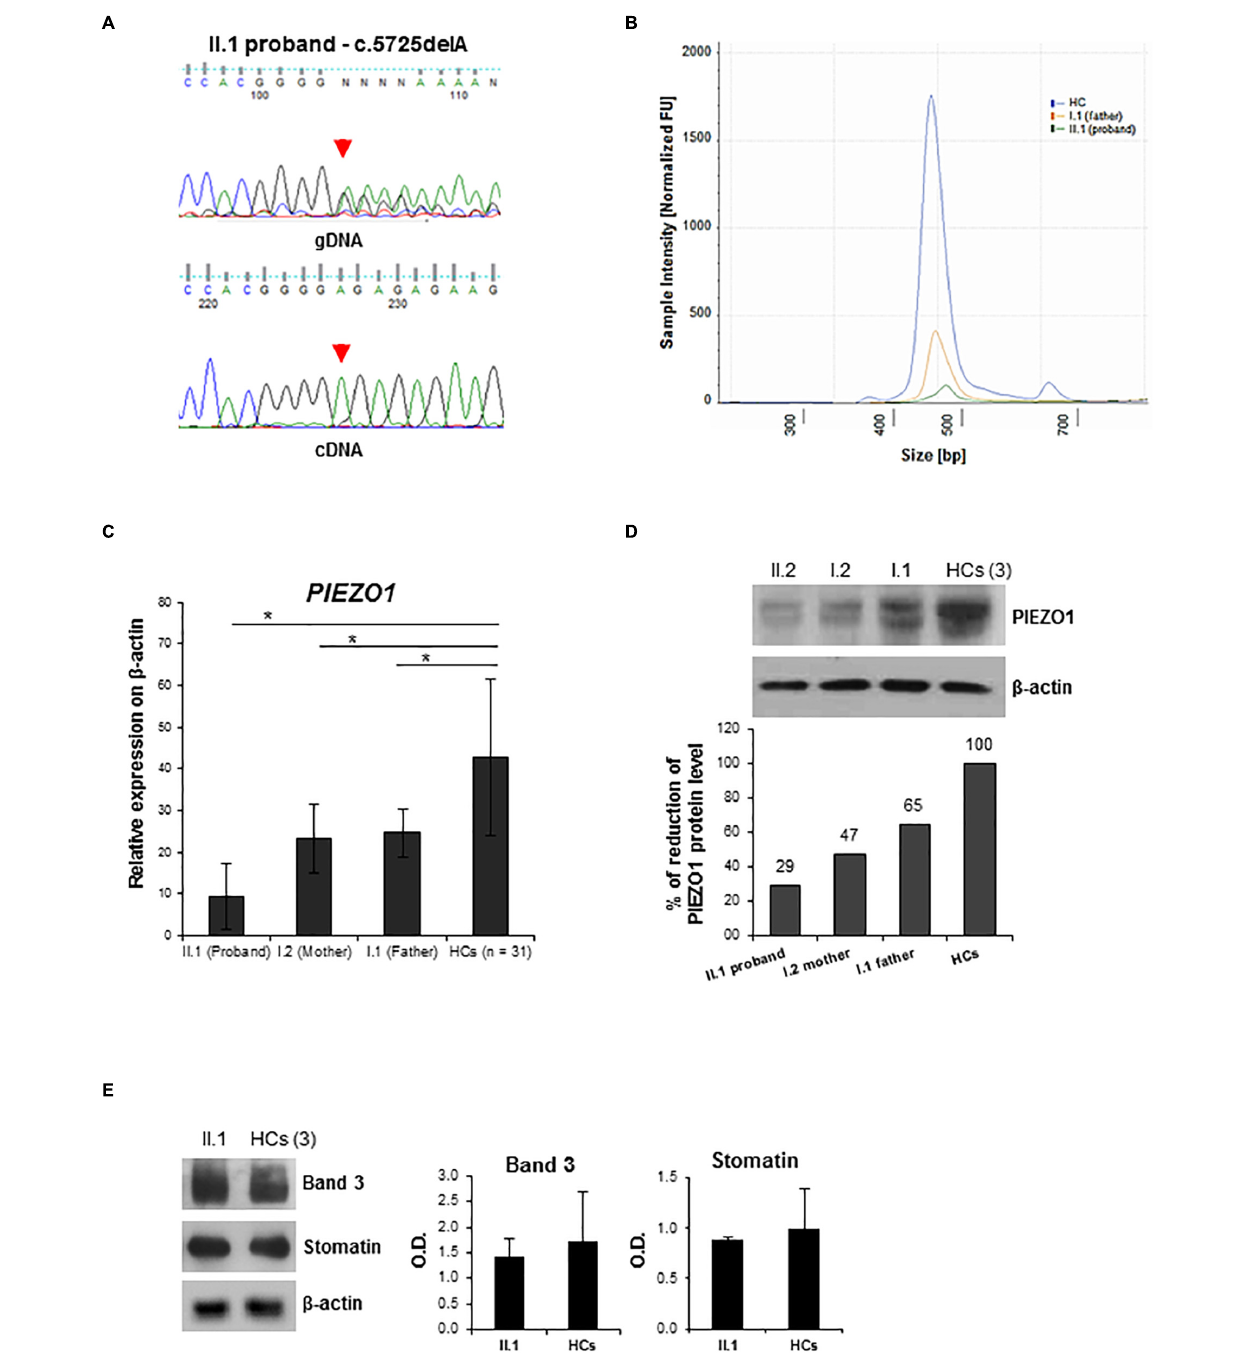
FIGURE 2 | Characterization of PIEZO1 mutations: cDNA study and membrane proteins expression analysis. (A) Electropherograms showing sequencing analysis of the PIEZO1 variant c.5725delA in the proband. Genomic DNA (gDNA) and cDNA sequences are shown. (B) DNA electrophoresis profile of the PIEZO1 cDNA fragment encompassing exons 42–44 of the proband (green line), the father (orange line), and the control (blu line) by 4200 TapeStation system. The electropherogram shows the size distribution and the intensity of the detected bands of RT-PCR. (C) PIEZO1 mRNA level normalized to GAPDH in the proband II.1 compared to his parents, I.1 and I.2 and the HCs ( n = 30). Data are presented as a mean ± SD. ∗ p -value < 0.05. (D) Immunoblot showing PIEZO1 protein expression normalized to β -actin in the proband II.1 compared to his parents, I.1 and I.2 and the HCs (pool of n = 3). Densitometric analysis of one representative western blotting is shown. (E) Immunoblot analysis of RBCs membrane proteins, Band 3 (Anion Exchanger 1) and Stomatin (Erythrocyte Membrane Protein 7.2), in the proband II.1 compared to the HCs (pool of n = 3). Protein levels are normalized to β -actin. Densitometric analysis of two separate western blotting is shown. Data are presented as a mean ±